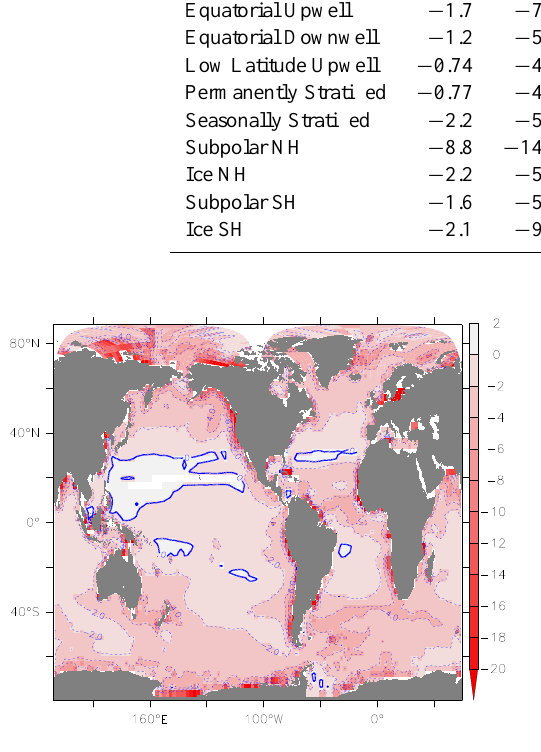
Figure 16. Difference in attenuation depth in m; chl&CDM minus model run using Eq.